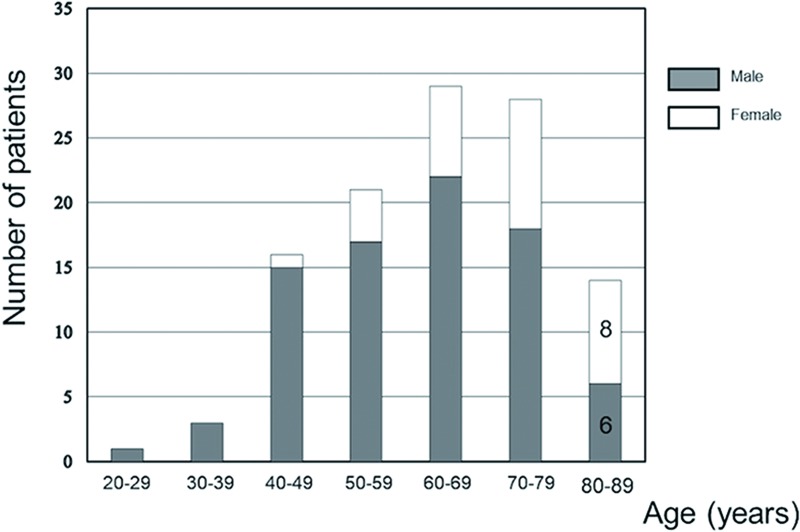
Bar graph showing the distribution of patients who underwent surgery for cervical spondylosis by age and sex.There were more female than male patients over the age of 80 years in the population.